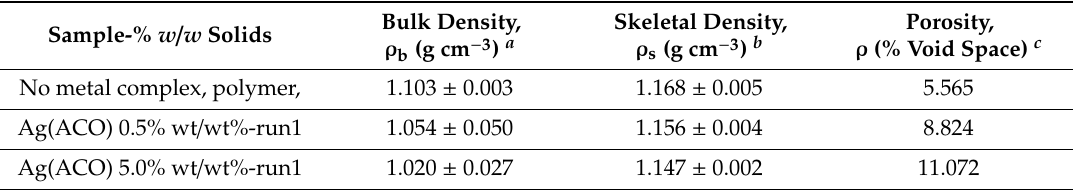
Table 2. Results of determination of densities and porosity of studied samples of acrylate polymeric composites (averaged